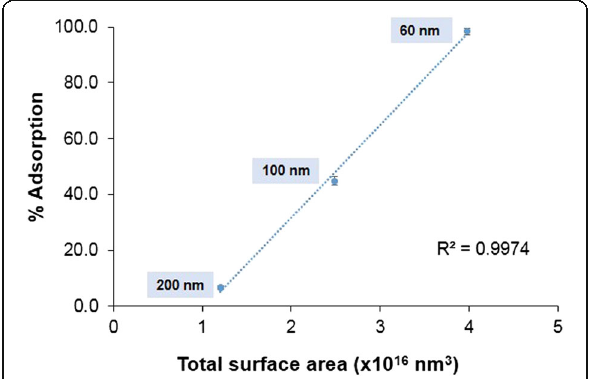
Fig. 6 Plot of adsorption percentage of tin onto silica nanoparticles and total surface area of incubated silica nanoparticles. Adsorption behavior of tin was determined by size of silica nanoparticles. Surface area increased along with decreasing nanoparticles